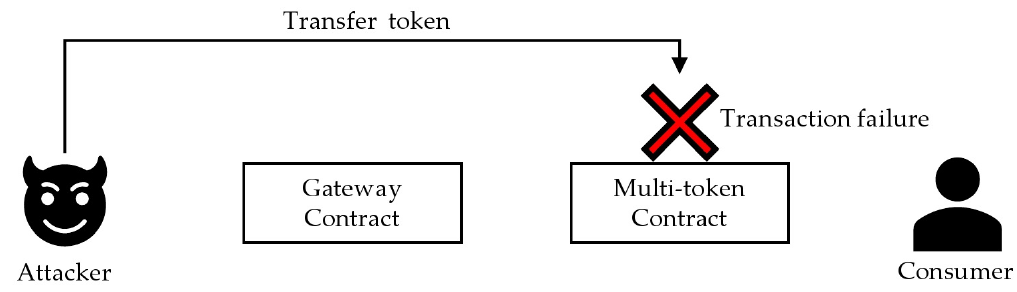
Figure 13. Transactions that do bypass the gateway contract fail.